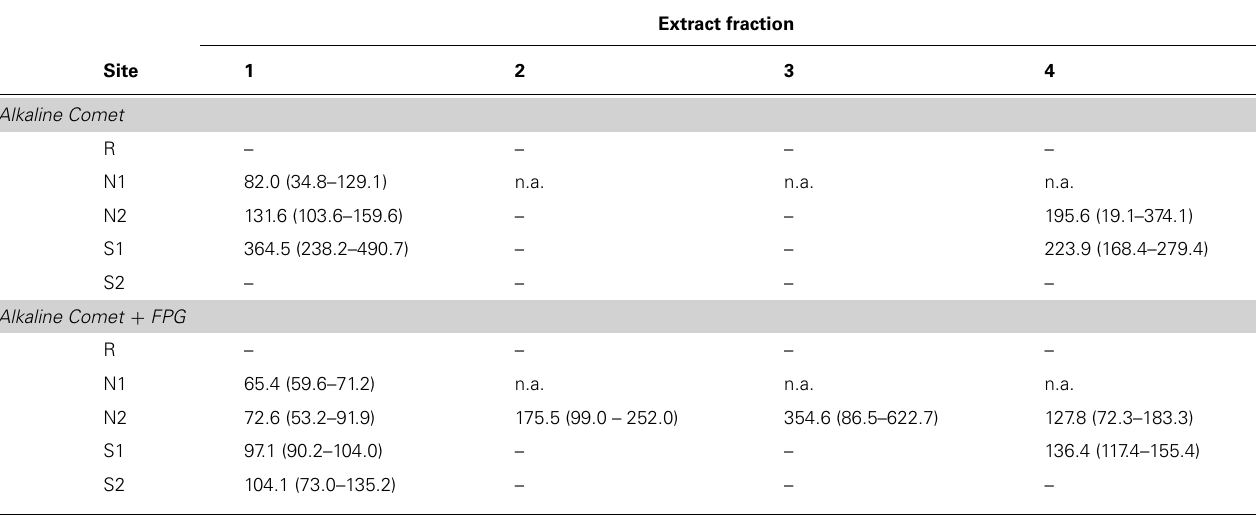
Table 4 | DNA damage EC 50 estimates (retrieved from the % of DNA in tail) for HepG2 cells exposed to each extract fraction for all surveyed sediment samples (in mg SEQ/mL) relatively to the maximum observed %DNA in tail throughout the study ( ≈≈≈ 30%). Extract